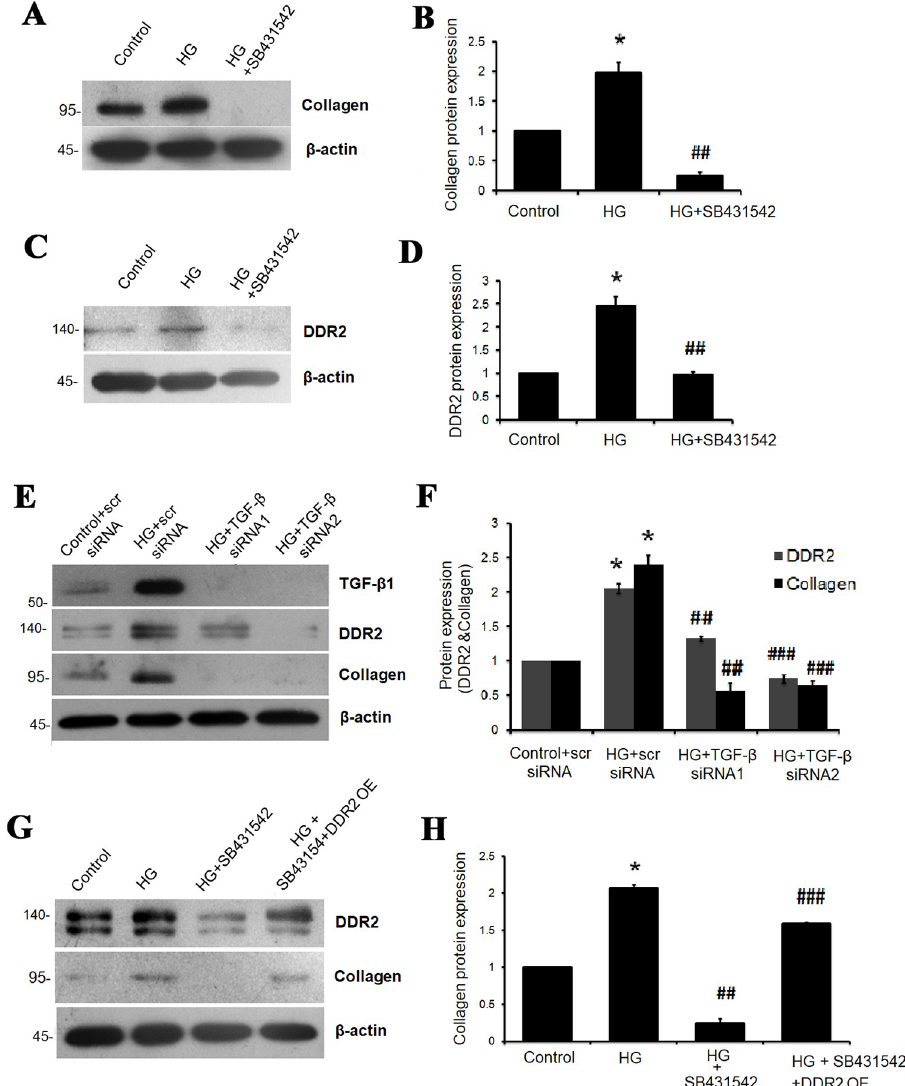
Fig 2. TGF- β 1 mediates HG-induced DDR2 and collagen gene expression. (A-D) Inhibition of TGF- β 1 abolished HG-induced collagen type I alpha 1 and DDR2 gene expression. Following pre-treatment of cells with TGF- β 1 inhibitor, SB431542, for 1 h and subsequently with HG for 12 h, (A and B) collagen type I alpha 1 protein expression � p < 0.05 vs. control, ##p < 0.01 vs. HG (One-way ANOVA p < 0.05), and (C and D) DDR2 protein expression � p < 0.05 vs. control, ##p < 0.01 vs. HG (One-way ANOVA p < 0.05) were examined by western blot analysis, with β -actin as loading control. (E and F) RNAi-mediated silencing of TGF- β 1 confirmed its role in regulating DDR2 and collagen gene expression. Vascular adventitial fibroblasts were transiently transfected with TGF- β 1 siRNA 1 and 2 (5 pmol) or scrambled siRNA prior to treatment with HG for 12 h. DDR2 ( � p < 0.05 vs. control, ## p < 0.01 vs. HG, ### P < 0.001 vs. HG) and collagen type I alpha 1 ( � p < 0.05 vs. control, ##p < 0.01 vs. HG, ###p < 0.001 vs. HG) protein expression was examined, with β -actin as loading control (One-way ANOVA p < 0.05). ( G and H) Effect of DDR2 over-expression on HG-induced collagen type I alpha 1 gene expression in TGF- β 1-inhibited adventitial fibroblasts. The ready-to- transfect DDR2 plasmid cocktail was added to the cultures for incubation in M199 for 8 h. After a recovery period of 12 h, cells were pre-treated with SB431542 followed by HG treatment. First lane confirms over-expression of DDR2. � p < 0.05 vs. control, ##p < 0.01 vs. HG, ###p < 0.001 vs. HG+SB431542 (One-way ANOVA p < 0.05). β -actin was used as the loading control. Data are representative of three independent experiments, n = 3. Error bars represent SD.